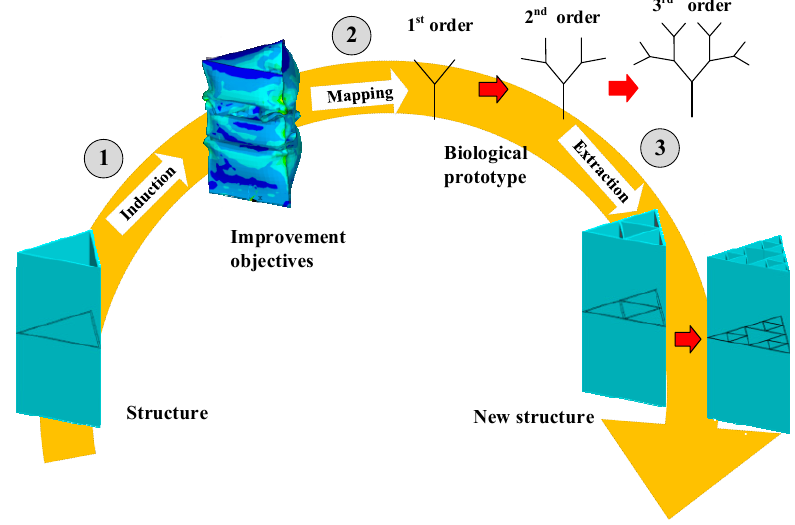
Figure 1. Main steps of the top-down bioinspired design method.